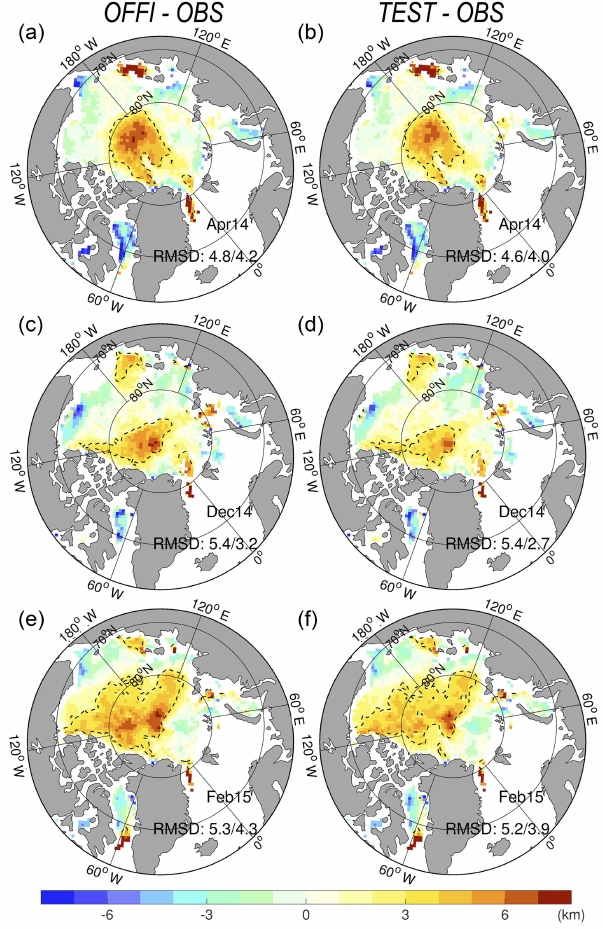
Figure 9. Sea-ice drift misfits (model minus observation, in km per 2 days) in the Official run (a, c, e) and Test run (b, d, f) , com- pared against the OSI-SAF sea-ice drift in April 2014 (a, b) , De- cember 2014 (c, d) and February 2015 (e, f) . The black dashed line delimits the area of fastest drift (drift > 3km per 2 days), and the RMSD relative to the monthly observations is indicated when cal- culated for the whole domain and at for the region north of 80 ◦